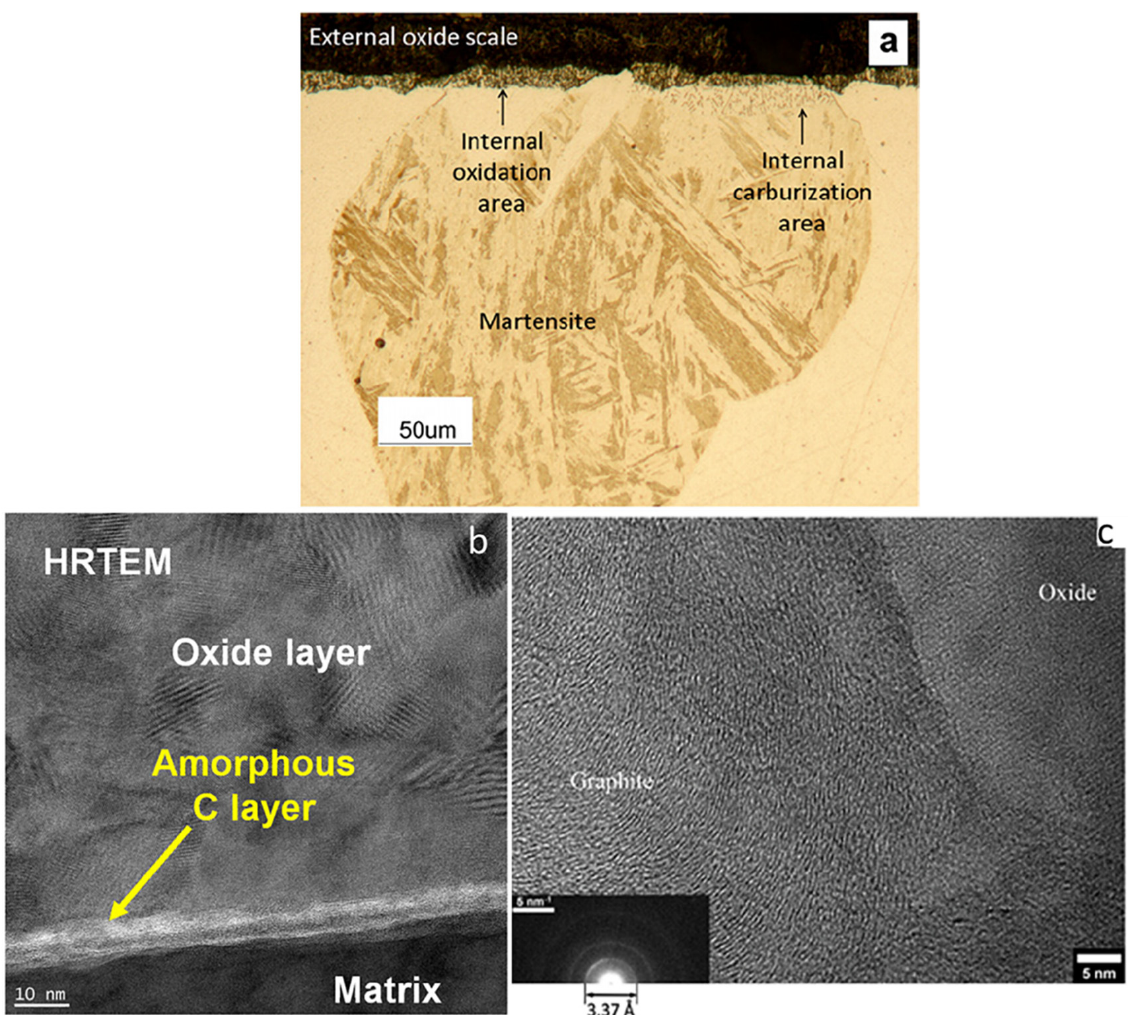
Figure 18. ( a ) Internal reaction products were observed in Fe9Cr alloy after exposure to 800 °C/1 bar Ar-20%CO 2 for 20 h [33]. Reproduced with permission from Elsevier. HRTEM analyses results of oxide layer: ( b ) Ni14Cr binary alloy corroded in 600 °C/20 MPa S-CO 2 for 200 h [97], reproduced with permission from Springer Nature. ( c ) Fe9Cr1Mo steel corroded in 600 °C/42 bar CO 2 for 20,000 h [104]. Reproduced with permission from Elsevier.